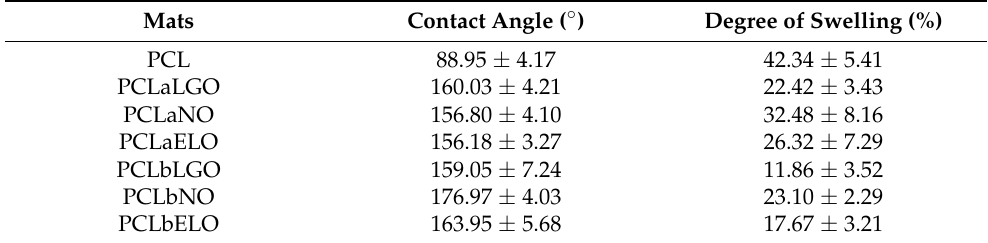
Table 6. Contact angles and degree of swelling determinations using dH 2 O as testing solution. Data is reported as mean ± S.D. ( n =